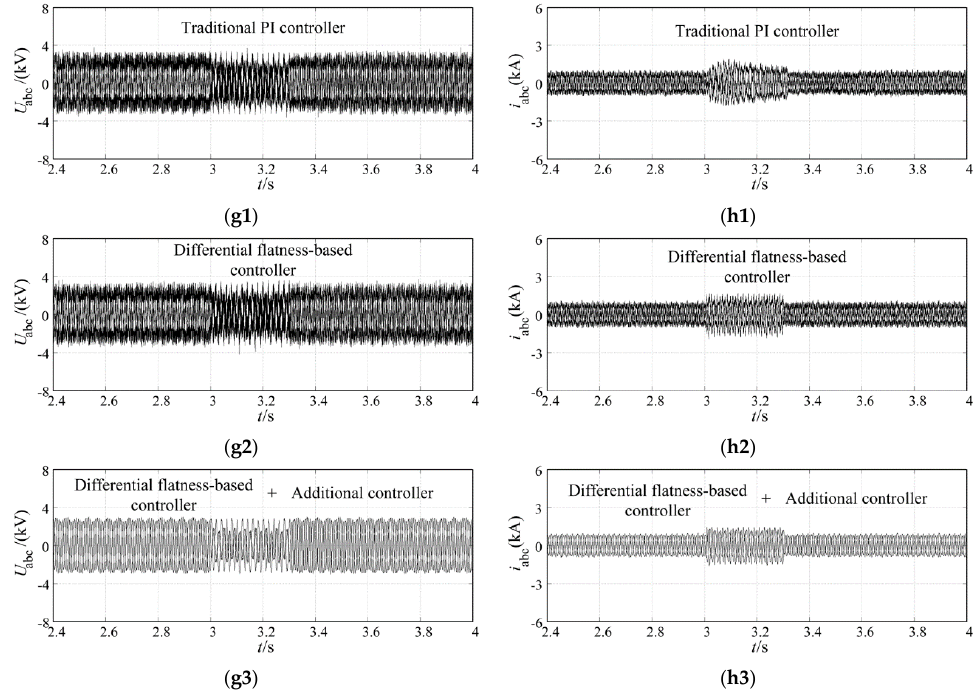
Figure 7. Simulation results of single-phase-to-ground grid fault condition. ( a1 – a3 ) DC voltage; ( b1 – b3 ) Second harmonic components of DC voltage; ( c1 – c3 ) Grid-side active power; ( d1 – d3 ) Second harmonic components of grid-side active power; ( e1 – e3 ) Grid-side reactive power; ( f1 – f3 ) Second harmonic components of grid-side reactive power; ( g1 – g3 ) Voltage at the low-voltage side of the transformer during grid short-circuit fault; ( h1 – h3 ) Current at the low-voltage side of the transformer during grid short-circuit fault.